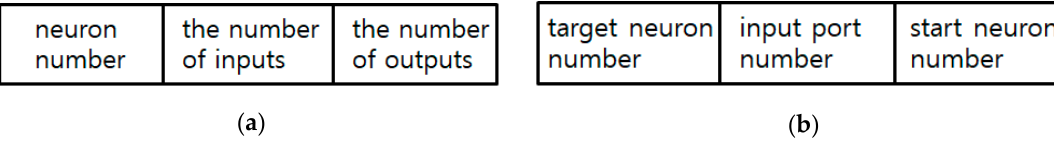
Figure 2. Chromosome type of neural network: ( a ) Chromosome type of neuron information and ( b ) chromosome type of linking information.